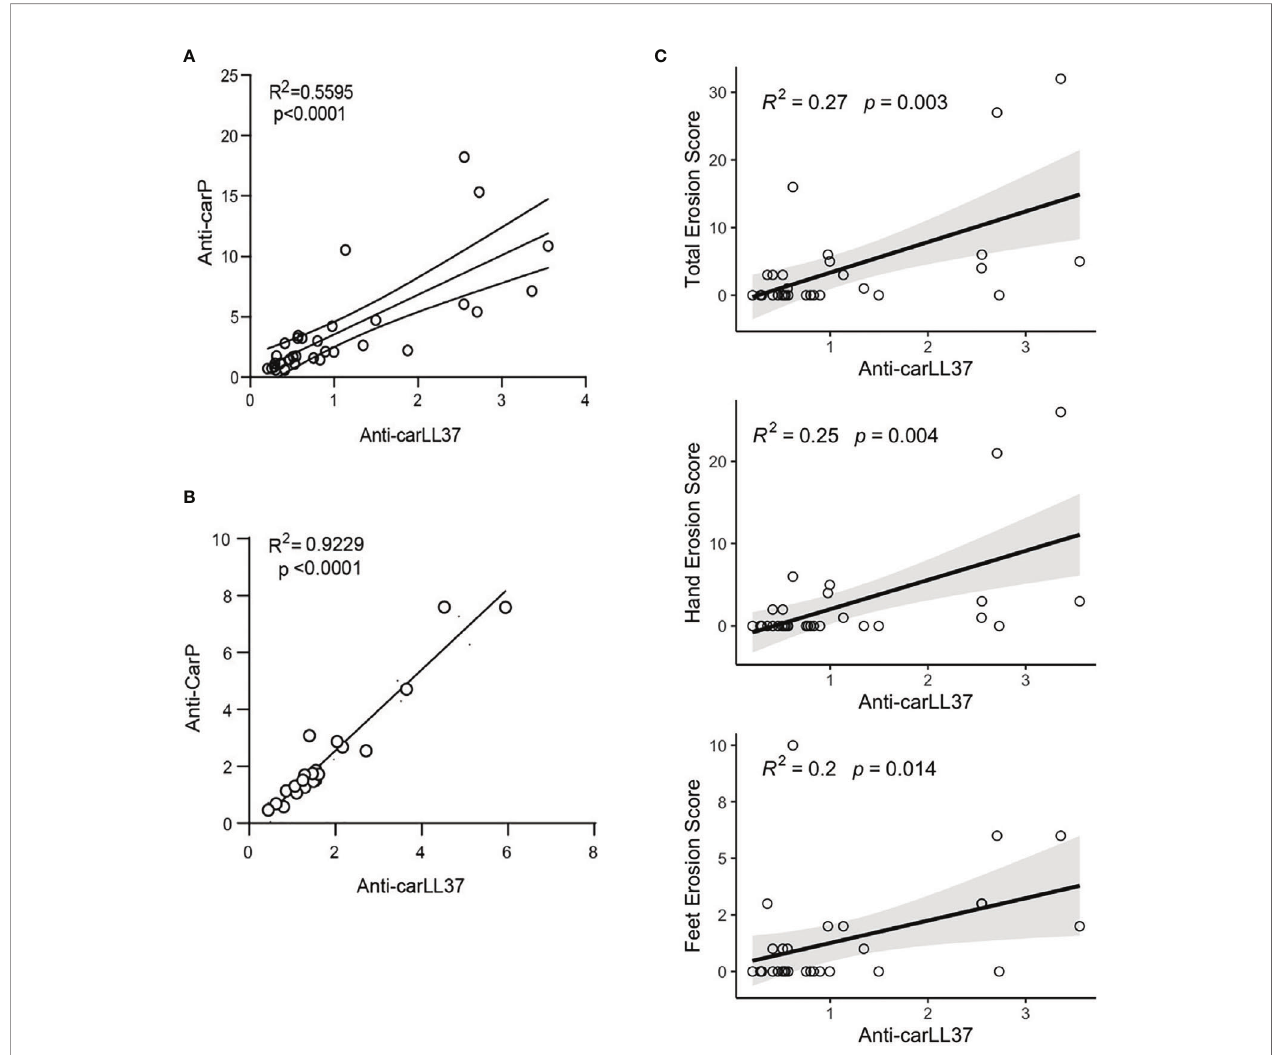
FIGURE 3 | Anti-carLL37 antibodies correlate with radiographic erosion scores in RA. Correlation of anti-CarP antibodies with antibodies against carbamylated LL37 in (A) serum and (B) synovial fl uid of RA patients (n = 15). (C) Correlation of total (top), hand (middle) or feet (bottom) radiographic erosions scores and antibodies against carbamylated